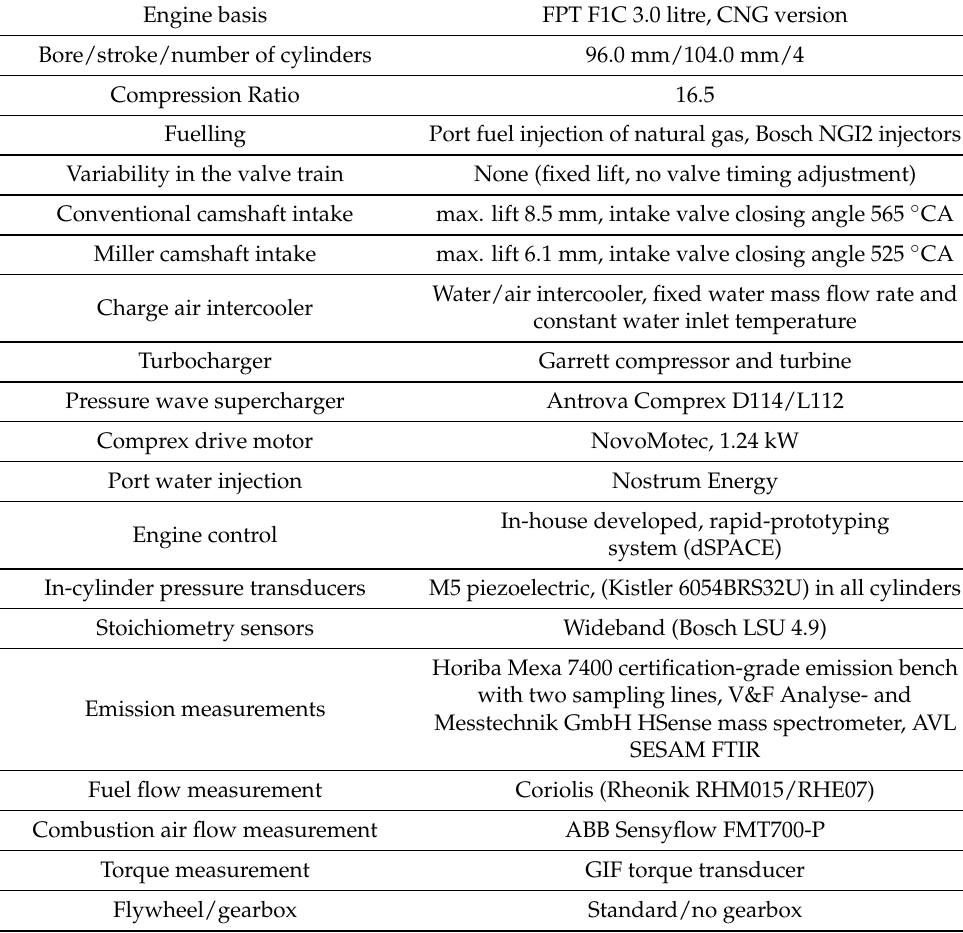
Table 1. Main characteristics of the experimental